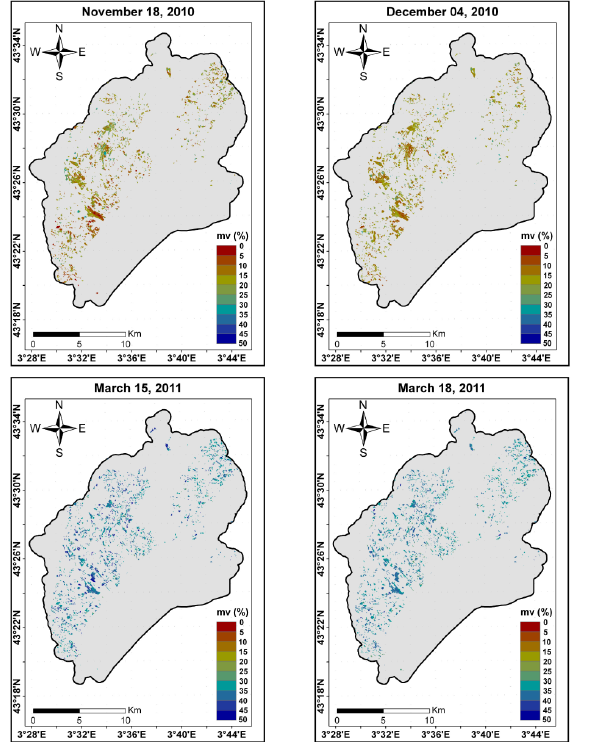
Fig. 6. Examples of soil moisture maps over bare agricultural areas for four different dates. The estimation of soil moisture was carried out for each bare agricultural parcel using expert knowledge on mv.